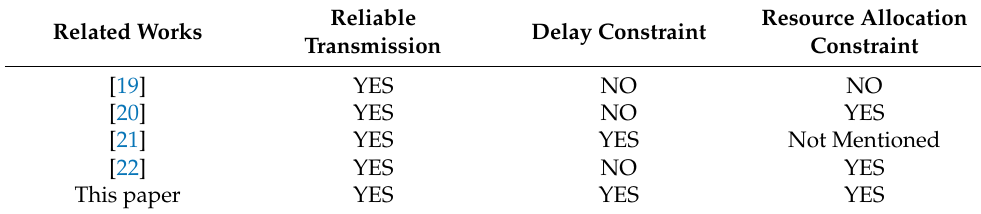
Table 2. Supported